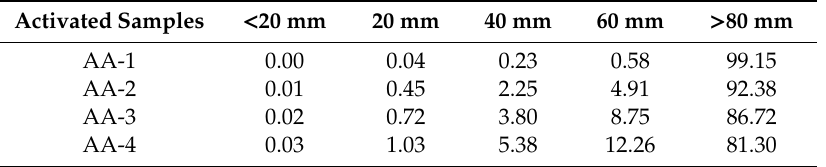
Table 10. Average Size of activated